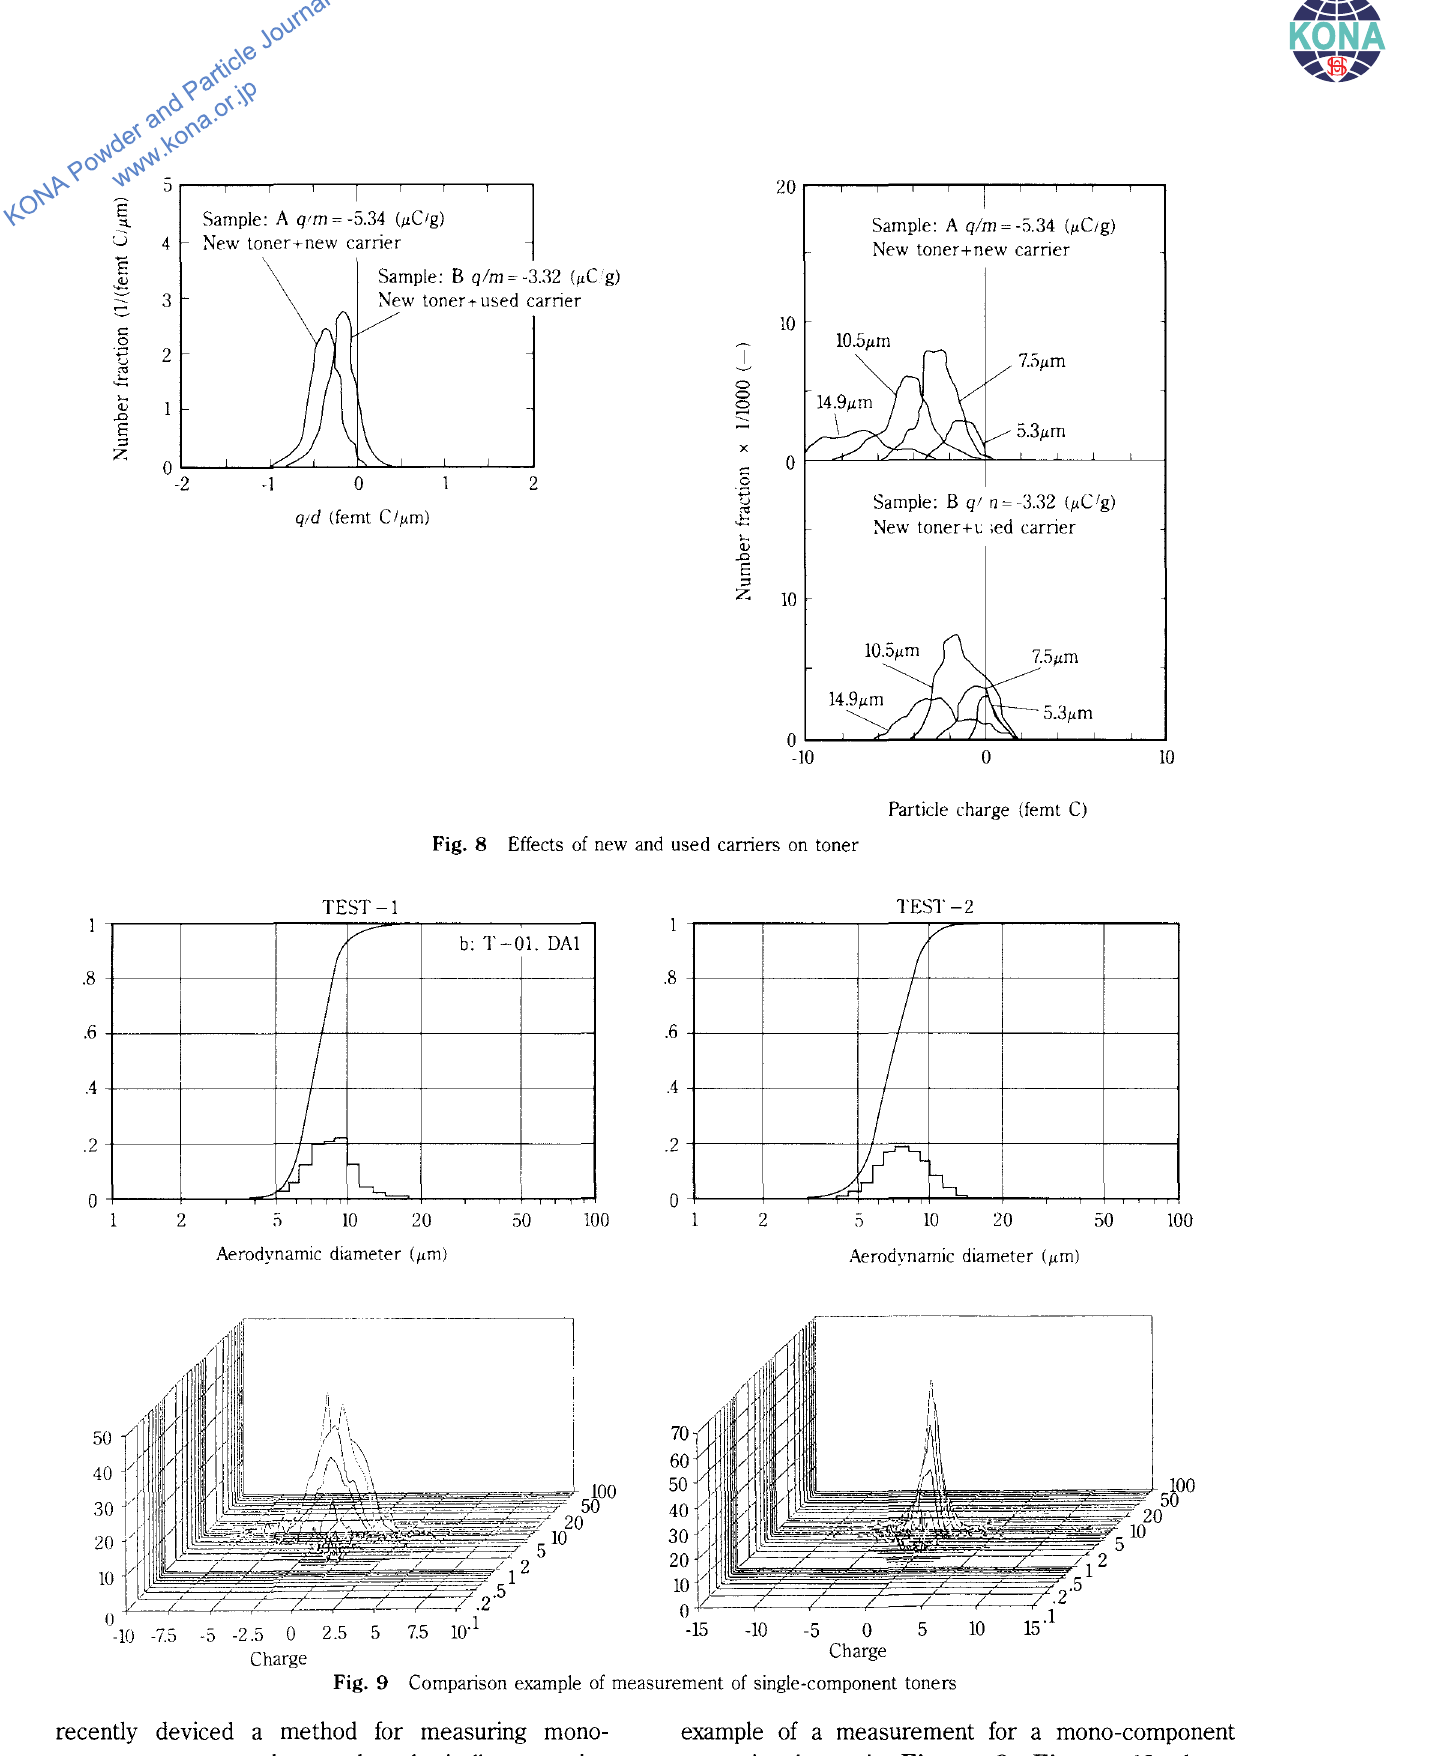
Fig. 8 Effects of new and used carriers on toner